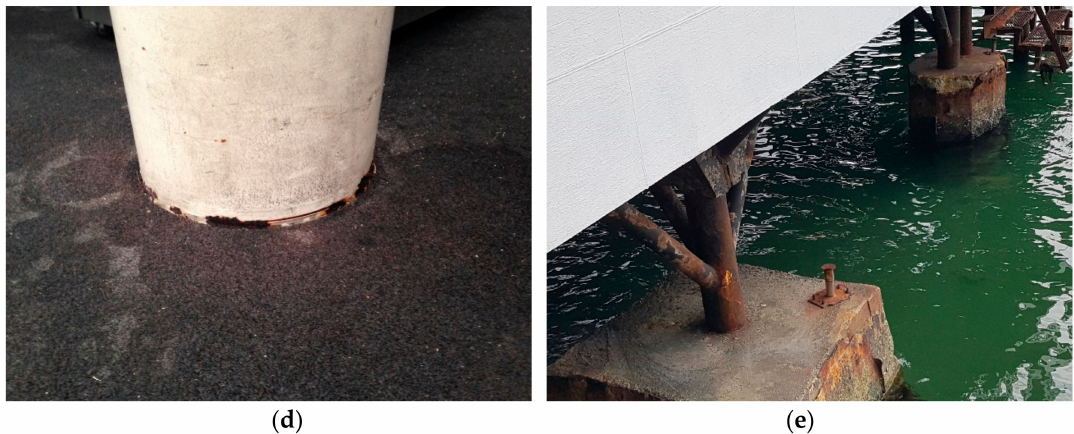
Figure 1. Occurrence of corrosion in short tubular steel columns: ( a ) Di ff erent exposure environments of an o ff shore structure; ( b ) Corrosion at ends; ( c ) Corrosion along the column; ( d ) Actual corrosion at ends; ( e ) Actual corrosion along the